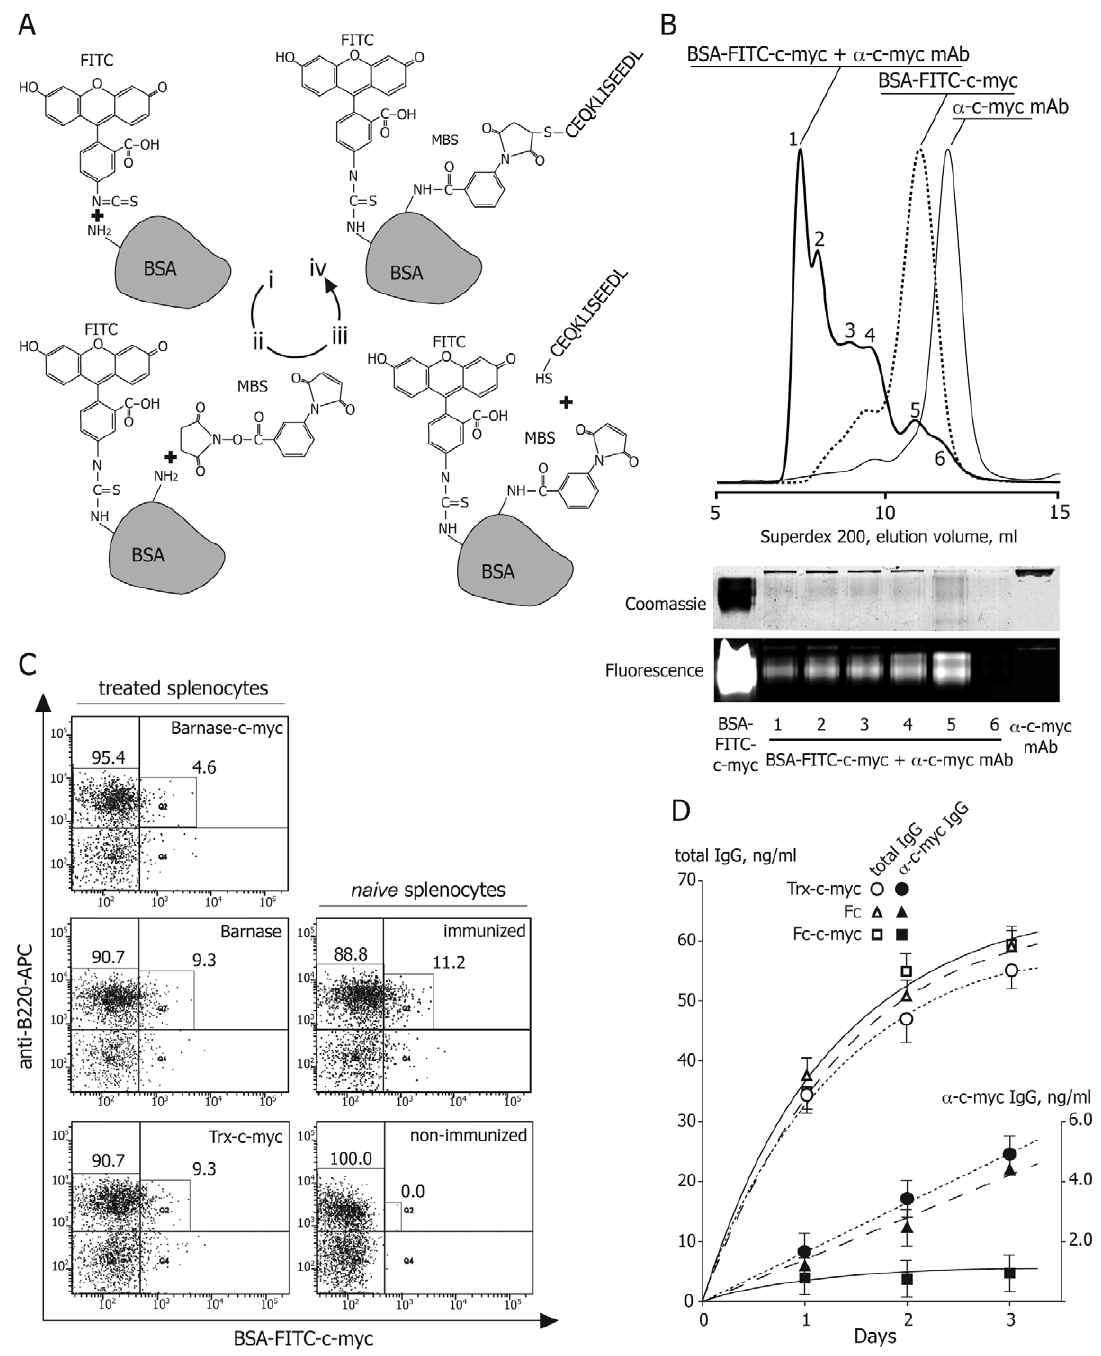
Figure 4. Barnase-c-myc and Fc-c-myc specifically deplete anti-c-myc B cells and decrease production of anti-c-myc Ab in culture of splenocytes, isolated from mice immunized by KLH-c-myc. (A) Procedure of obtaining of BSA-c-myc conjugate labeled by FITC for flow cytometry detection of targeted anti-c-myc B cells. (i) Conjugation of BSA with FITC using coupling of isothiocyanate with primary amino groups. (ii) Reaction of free primary amino groups of BSA-FITC with MBS. (iii) Coupling of second functional group of MBS with SH group of N-terminal cysteine, flanking c-myc peptide. (iv) Final bifunctional reagent BSA-FITC-c-myc, which is capable to react with BCR on the surface of B cells due to the attached c-myc peptide and carrying fluorescein group for detection. (B) Binding of anti-c-myc mAb to BSA-FITC-c-myc in solution. Superdex 200 gel- filtration profile of BSA-FITC-c-myc alone (dashed line) and preincubated with anti-c-myc mAb (solid line). Anti-c-myc mAb are shown by thin solid line. Fractions from gel-filtration chromatography of BSA-FITC-c-myc preincubated with anti-c-myc mAb were subjected on PAGE and visualized by coomassie staining and measurement of FITC fluorescence emission (bottom panel). (C) Representative flow cytometry analysis of native splenocytes, isolated from non-immunized and immunized by KLH-c-myc mice, using BSA-FITC-c-myc and anti-B220 APC-labeled antibody (right panels). Approximately 11% of all B cells carry BCR specific for c-myc peptide (B220 high BSA-FITC-c-myc high , Q3 quadrant). Representative flow cytometry analysis of splenocytes, isolated from mice immunized by KLH-c-myc, treated by barnase-c-myc, barnase and Trx-c-myc (left panels from top to bottom). (D) Analysis of total antibody titer (open figures) and anti-c-myc Abs (filled figures) in samples of splenocytes, isolated from KLH-c-myc immunized mice, treated by Trx-c-myc (circles), Fc (triangles) and Fc-c-myc (squares) molecules. Bars represent standard deviation (n=3).